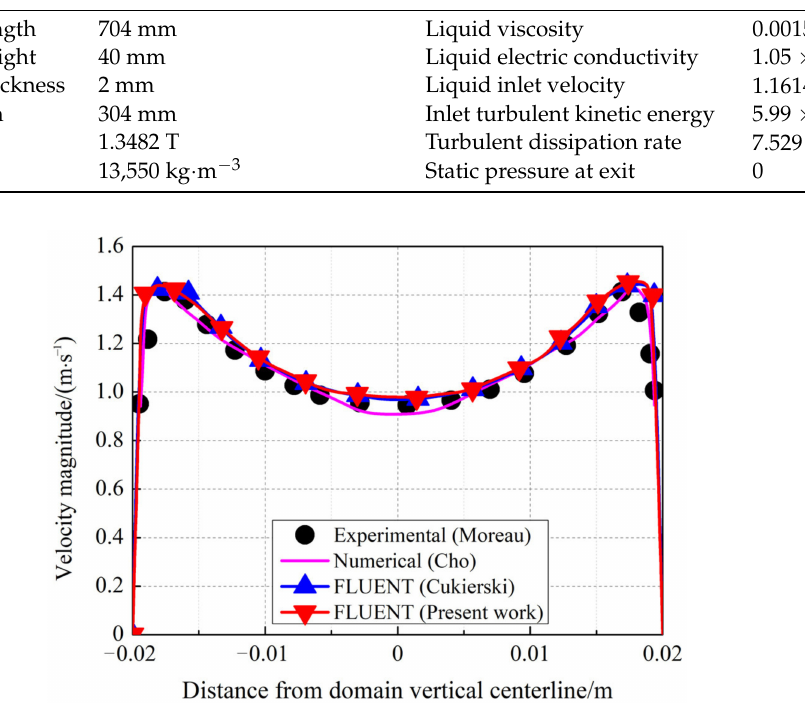
Figure 3. Velocity profiles along a vertical line at the horizontal center of MHD computational